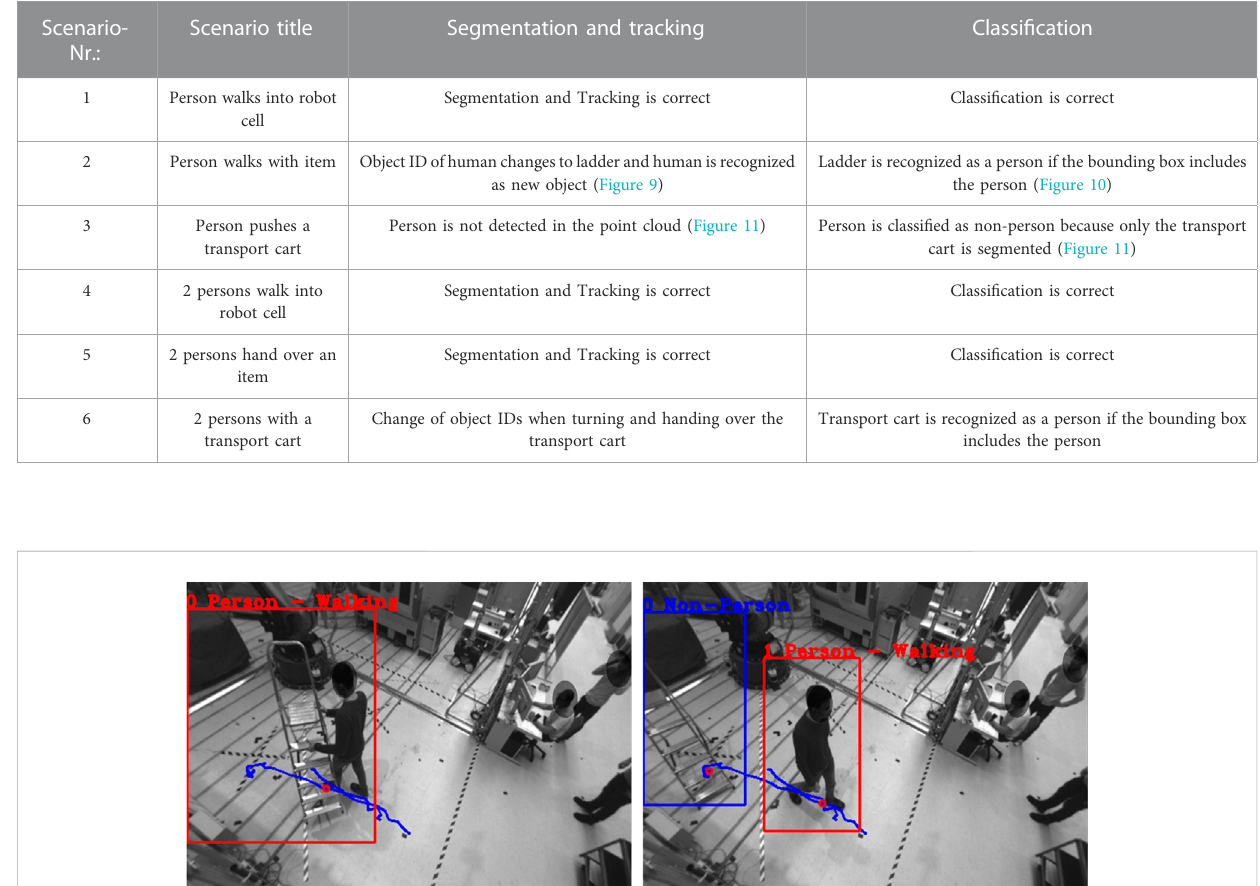
TABLE 3 Summary of the qualitative assessment. Scenario- Nr.: